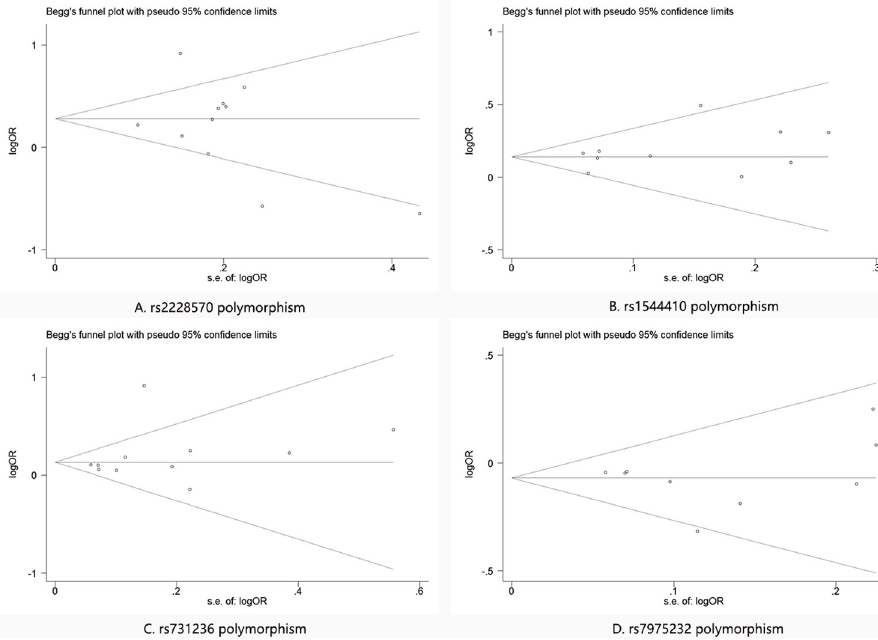
Fig 4. The Begg’s plot of Publication bias for the VDR polymorphism. A: rs2228570 polymorphism; B: rs1544410 polymorphism; C: rs731236 polymorphism; D: rs7975232 polymorphism. CAD = Coronary artery disease, VDR = vitamin D receptor, OR = odd ration, CI = confidence